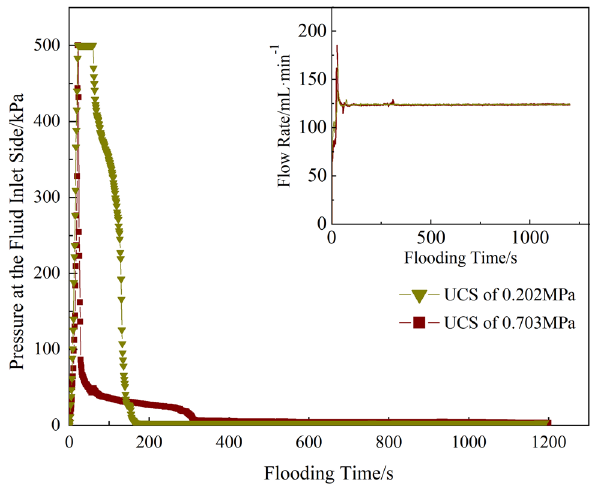
Fig. 12 Relationship between the cavity volume ratio and the water flooding time in wormhole sanding